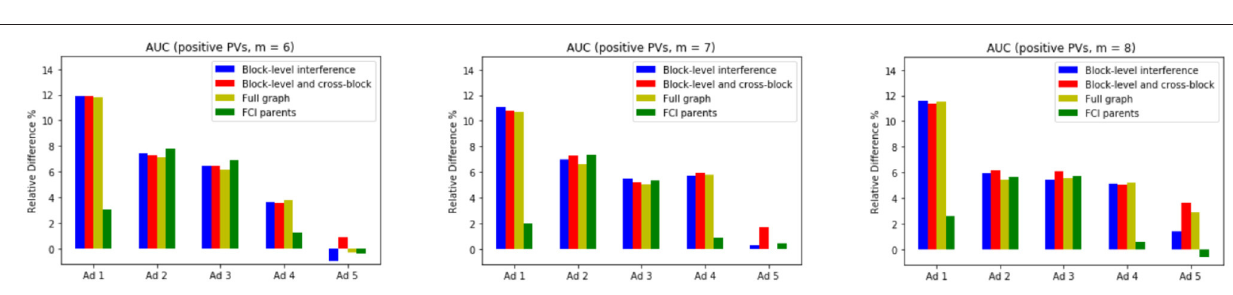
FIGURE 4 | Relative difference (in percentage) in AUCs with respect to the baseline model in unseen